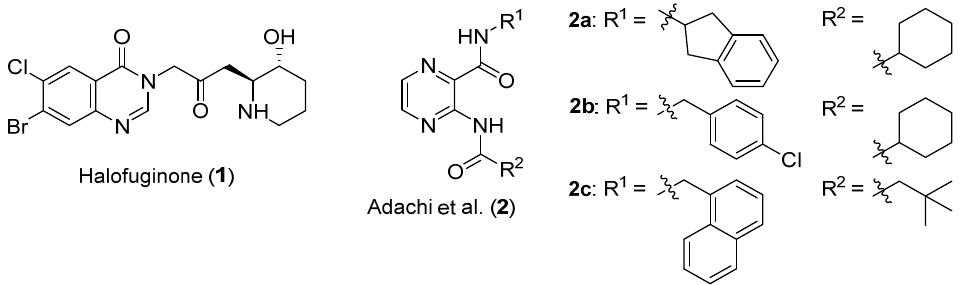
Figure 1. Chemical structures of halofuginone ( 1 ) [10] and confirmed HcProRS inhibitors 2a , 2b , 2c